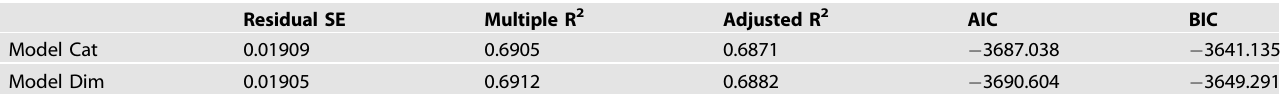
Table 3. Comparison of measures to assess model fi t between categorical (Model Cat) and dimensional model (Model